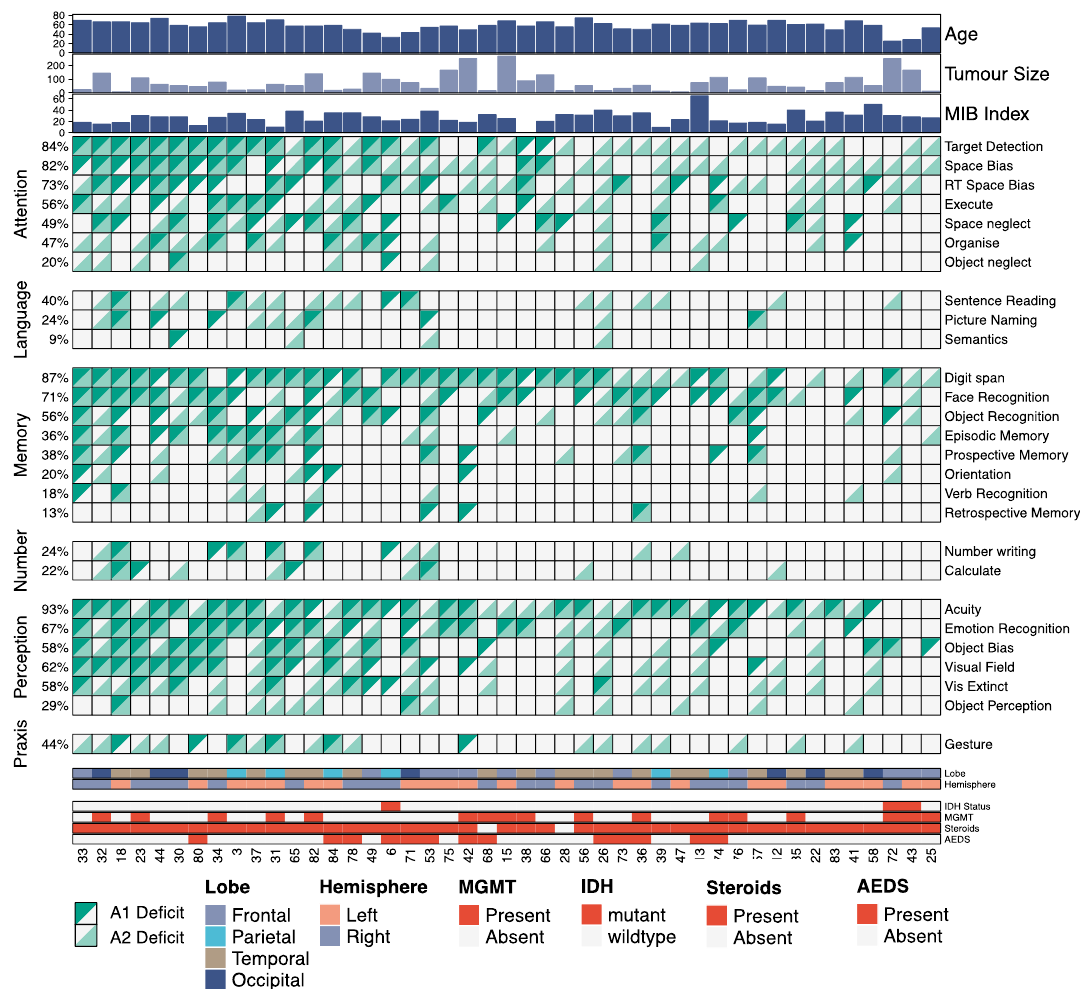
Figure 1. Summary of cohort characteristics. Each column represents one patient. For the heatmap, each square represents the cognitive status of a patient at A1 (top left triangle) and A2 (bottom right triangle). Information relative to the clinical characteristics of each patient is annotated at the top and bottom of the heatmap.